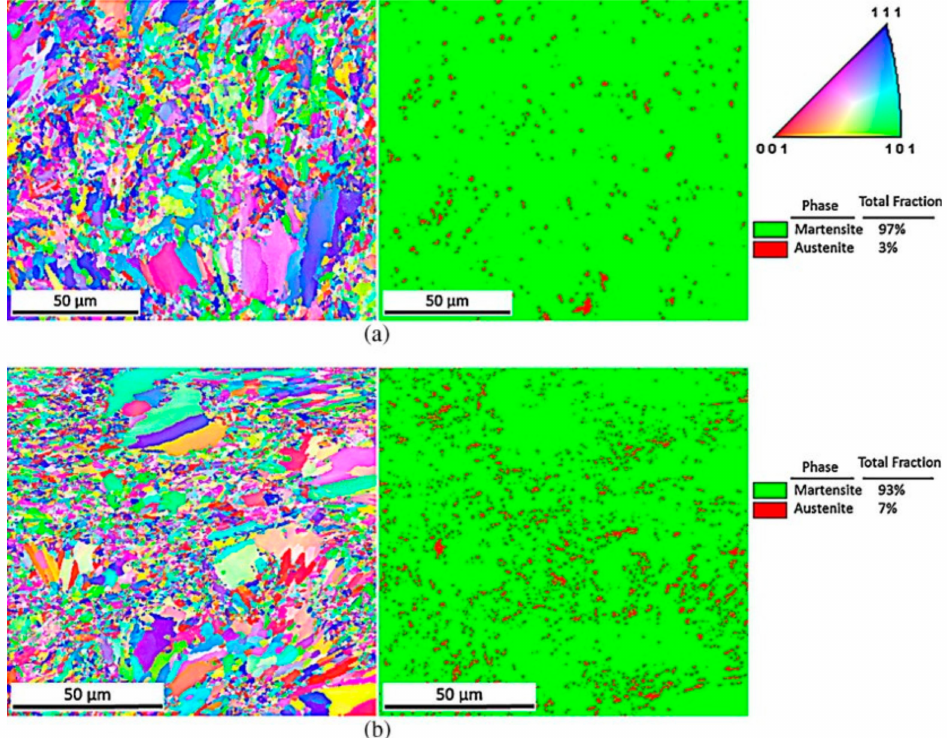
Figure 7. EBSD maps of selected areas in the middle region of ( a ) vertical and ( b ) horizontal as-built (AB) samples [26], material: 17–4